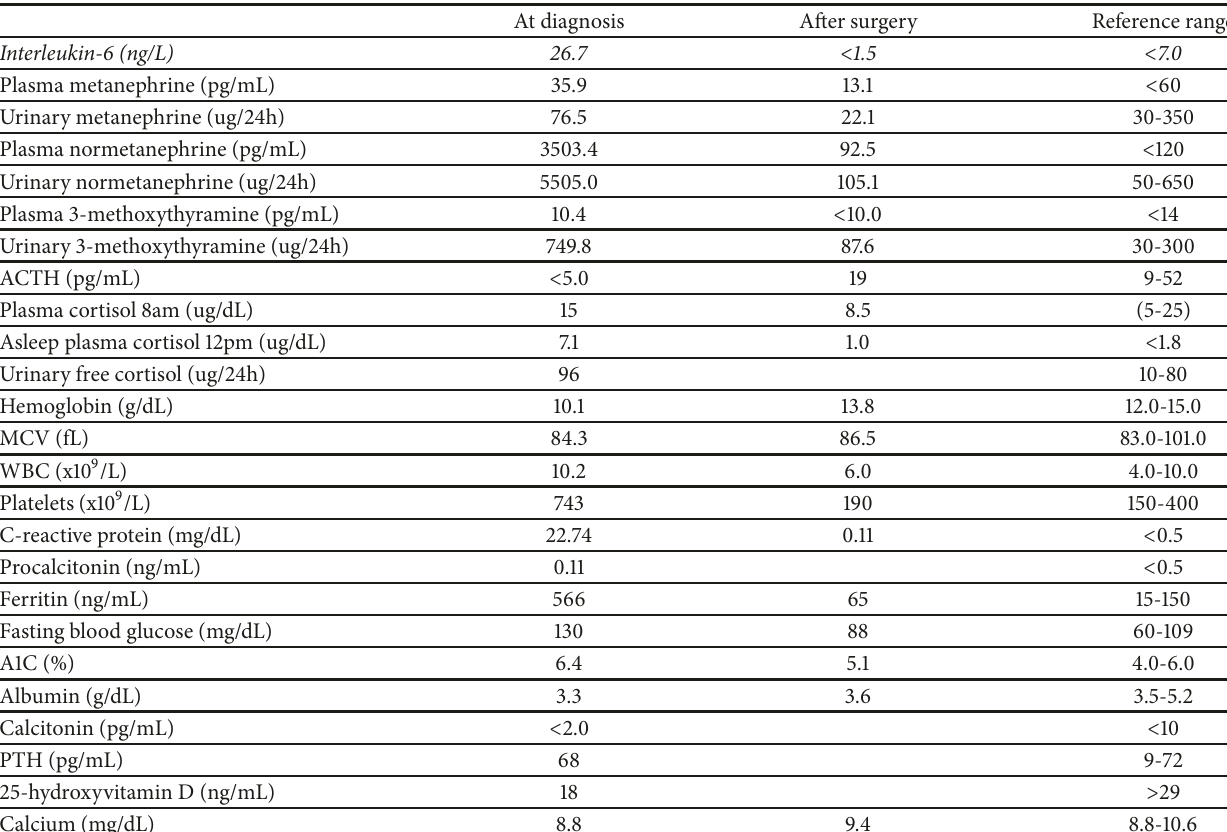
Table 1: Laboratory data before and after left adrenalectomy.